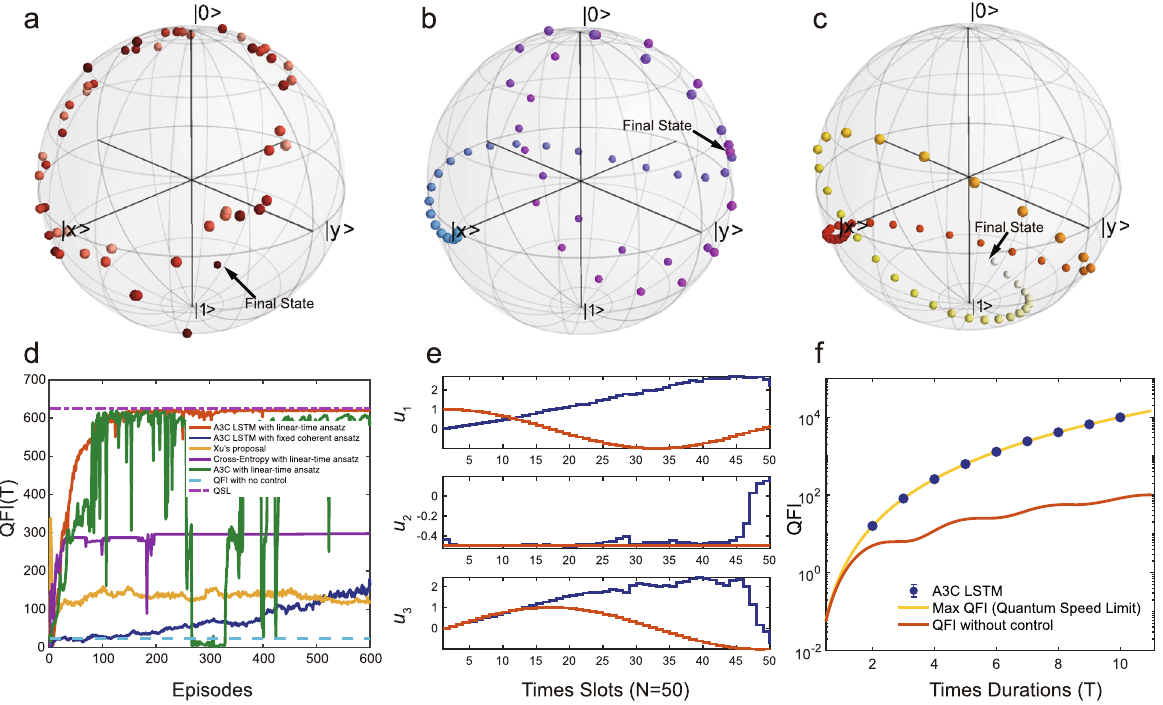
Fig. 5 Simulation results of quantum fi eld frequency estimation where A = 1, ω = 1. a – c are Bloch sphere visualization of the qubit evolution where T = 5, Δ t = 0.1. The darkest color dot represent the fi nal evolution of the qubit. a denotes evolution with the DRL-based control, b denotes no controls are applied, and ( c ) denotes the optimal coherent control ( d ) displays the QFI learning curve at the fi nal time under different schemes varied with episodes where T = 5, Δ t = 0.1 for A3C LSTM, A3C and Xu ’ s proposal, elite ratio is 10% and number of agents is 50 for Cross-Entropy method. e plots the optimized control signals produced by DRL and explicit strategy. f are the results QFI with different time durations where Δ t = 0.5 for T = 10 and Δ t = 0.1 for other T . Error bar is the standard error of the